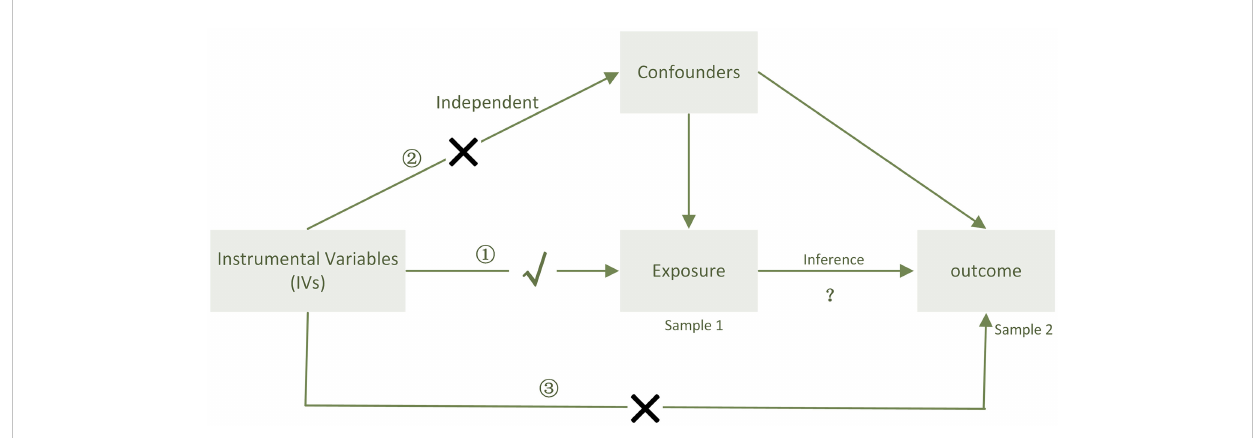
FIGURE 5 When sample 1(exposure) and sample 2(outcome) are used for causal estimates in MR inference, three assumptions must be satis fi ed (11). ① Relevance assumption: the genetic variations are highly related to the exposure, ② independence assumption: the genetic variants are not associated with any putative confounder of the association between exposure and result, and ③ exclusion restriction: the variants do not alter the outcome independently of